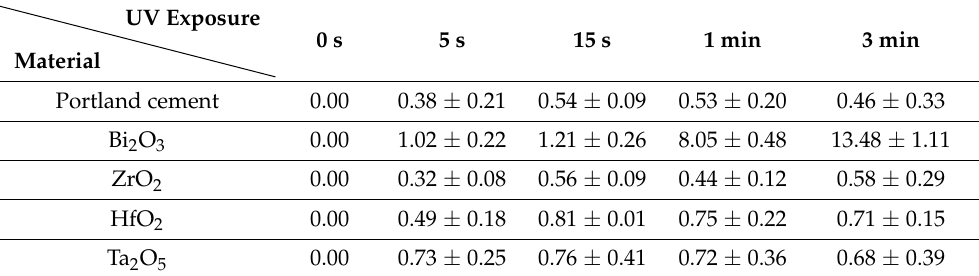
Figure 3. ( a ) Photos and ( b ) corresponding ∆ E 00 values for MTA-like cements prepared using as-milled oxide powder and irradiated under UV exposure. Table 2. ∆ E 00 results for the accelerated discoloration